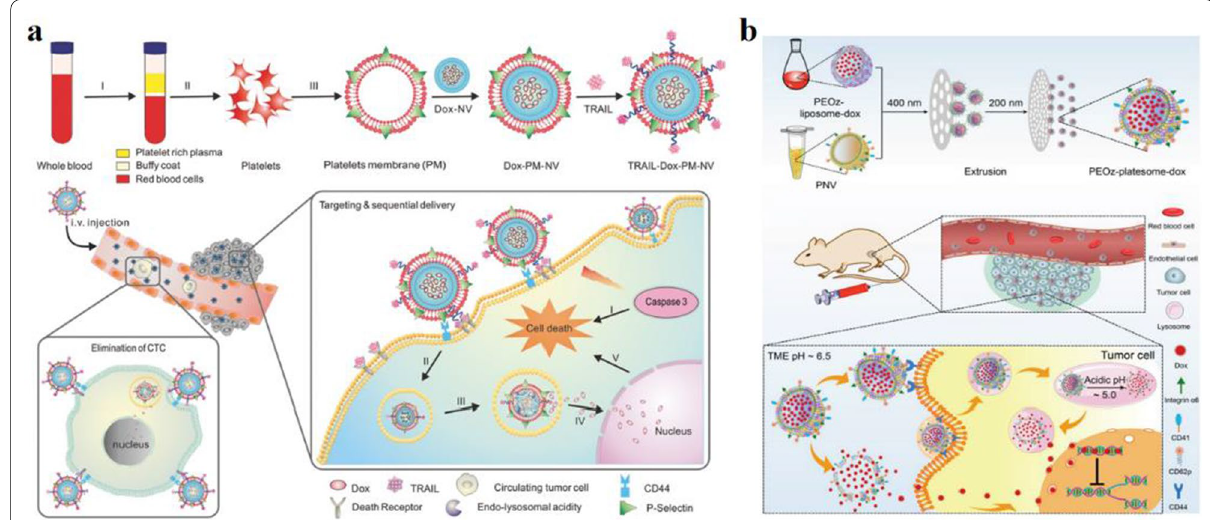
Fig. 3 a Schematic design of drug-loaded PM-NV for targeting and sequential drug delivery [48]. Copyright 2016 Adv. Mater. b Schematic design of engineering biomimetic nanocarrier for pH-responsive drug delivery and enhanced anti-tumor activity [49]. Copyright 2019 WILEY–VCH Verlag GmbH & Co. KGaA,